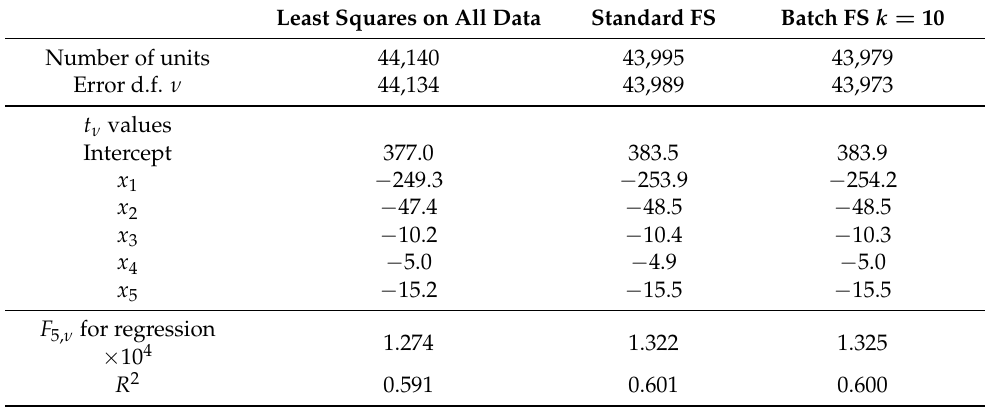
Table 1. Balance sheet data: summary properties of regression for least squares computed on all data (column 2), for a standard FS (column 3) and SAS batch with k = 10 (column 4). Least Squares on All Data Standard FS Batch FS k = 10 Number of units